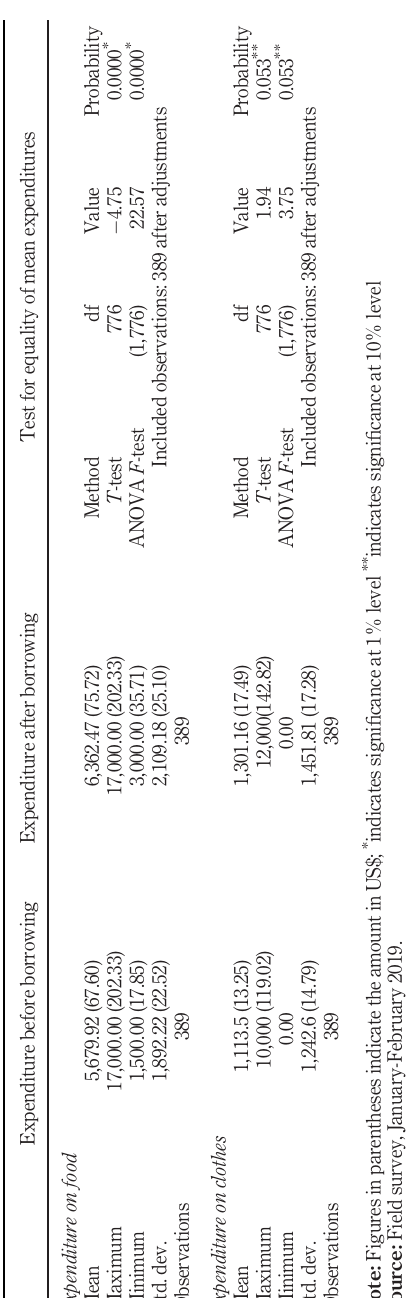
Table 8. Respondents ’ monthly family consumption expenditure